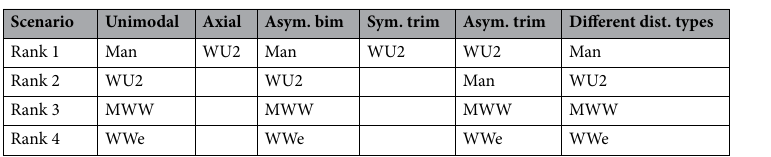
Table 2. Ranking of tests based on the power comparisons for the main scenarios encountered in potential data sets (using different distributions: unimodal, axial, asymmetrical bimodal, symmetrical trimodal, asymmetrical trimodal), in cases were only one test performed acceptable the others ranks were left blank (see Table 1 for